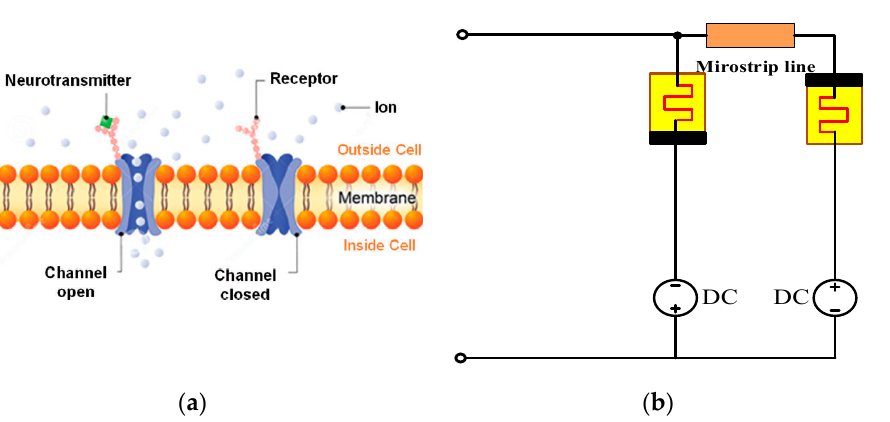
Figure 8. The neuron and the VO2 Neuristor Based on Microstrip Line Coupling. ( a ) The Illustration of neuron [13]; ( b ) The artificial neuristor model.